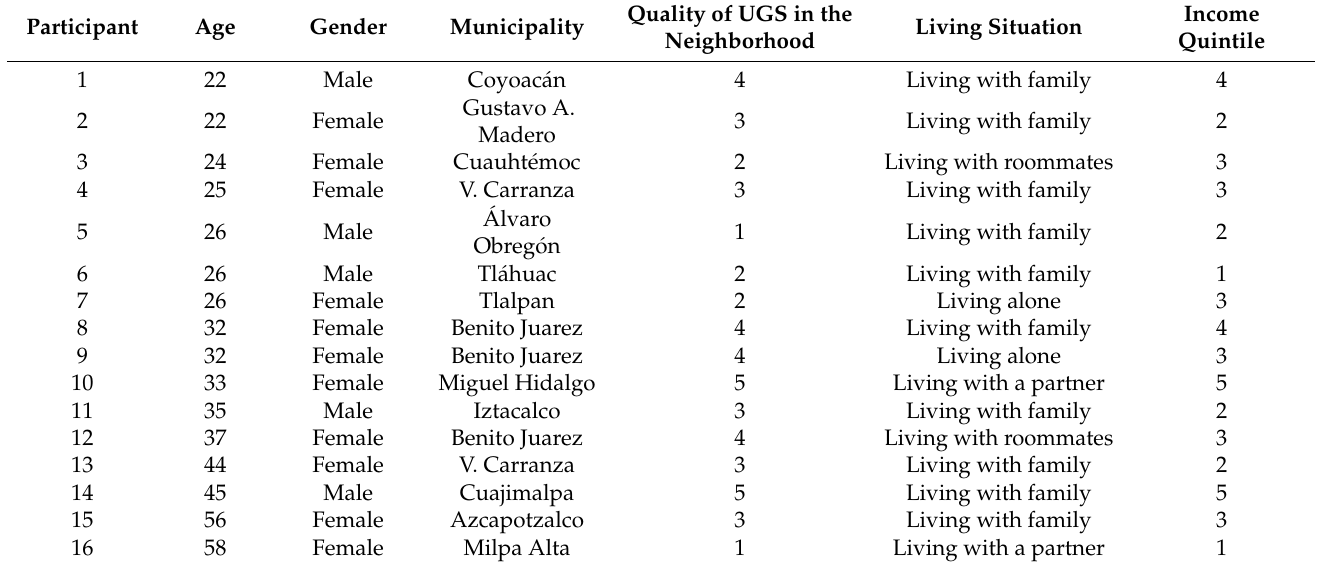
Table 1. Participant